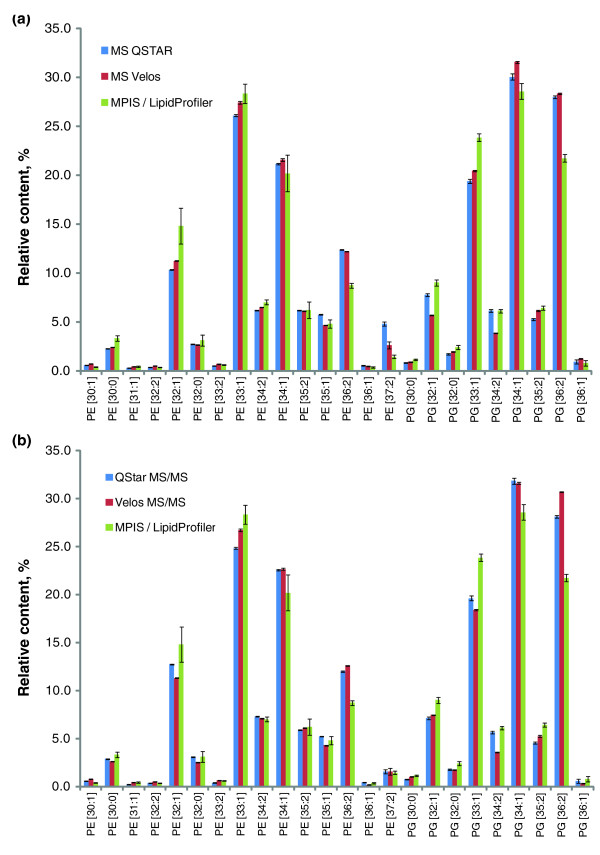
LipidXplorer supports the interpretation of spectra acquired using different mass spectrometers. (a) Comparison of the relative abundances of 24 major PE and PG lipid species identified in a total E. coli extract in MS and data-dependent MS/MS modes on the LTQ Orbitrap Velos (red bars) and QSTAR Pulsar i (blue bars) mass spectrometers, while spectra were interpreted by LipidXplorer. The same extract was analyzed by MPIS on the QSTAR Pulsar i and LipidProfiler software (green bars). Species abundances were normalized to the total abundance of the lipid class; error bars (standard deviation) were calculated on the basis of six experiments. Correlation coefficients and slopes of scatter plots for each pair-wise comparison are presented in Table 5.